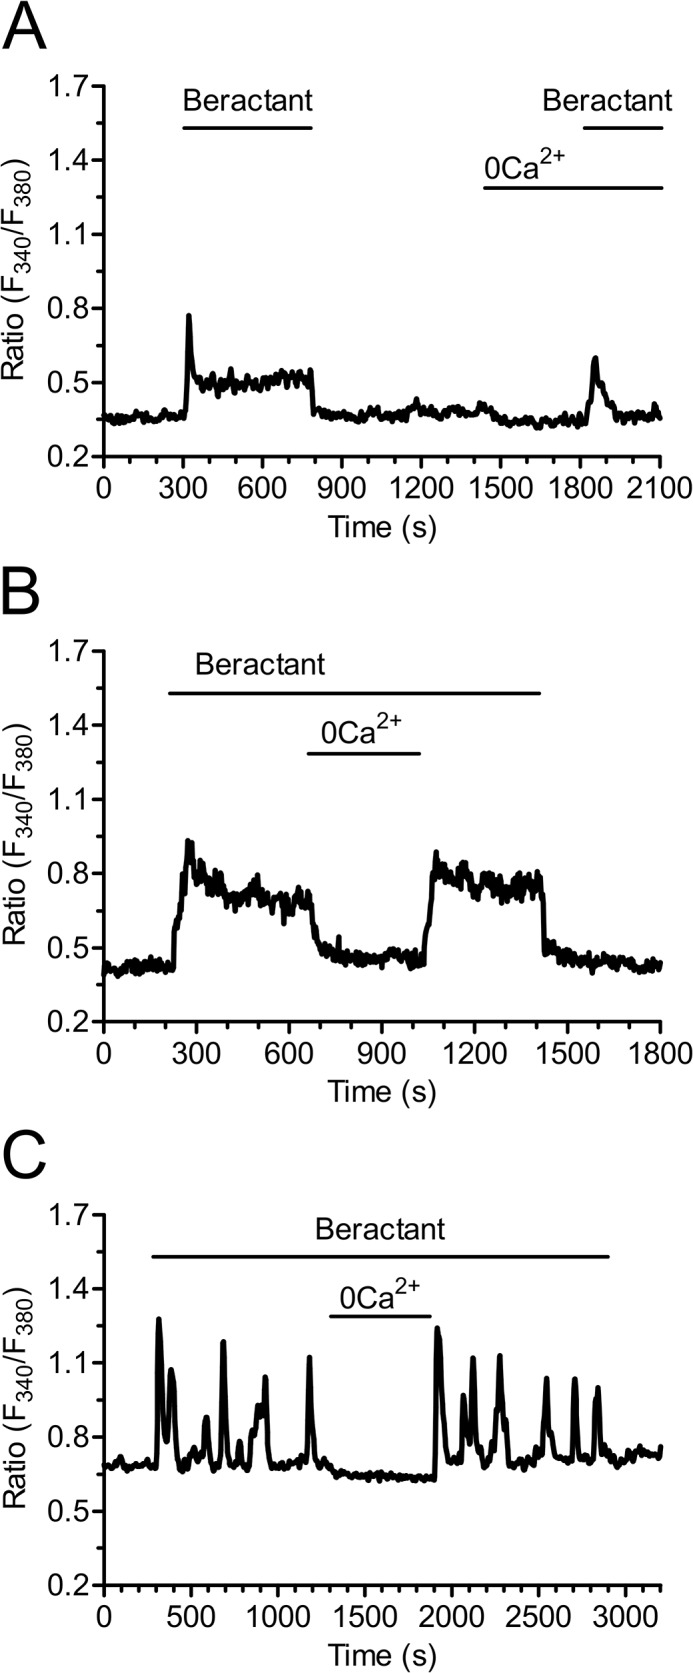
Effect of extracellular Ca2+ removal on the Ca2+ response to beractant.
A) Ca2+ signal elicited by beractant in the presence and absence of extracellular Ca2+ (0Ca2+) in the same single cell. Note that the prolonged decay phase did not occur in absence of extracellular Ca2+. B) Withdrawing extracellular Ca2+ (0Ca2+) during an established response to beractant (500 μg/ml) immediately interrupted the Ca2+ plateau and C) repetitive Ca2+ oscillations. The Ca2+ plateau and Ca2+ oscillations resumed upon readmission of external Ca2+.